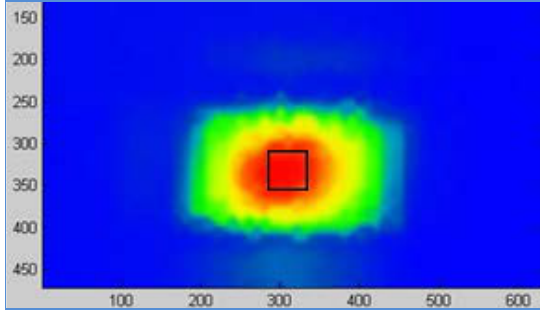
Figure 23. Anomaly point of coal fire thermal image The more than 25 sets of physical temperature values with respect to the surface of coal for measuring the